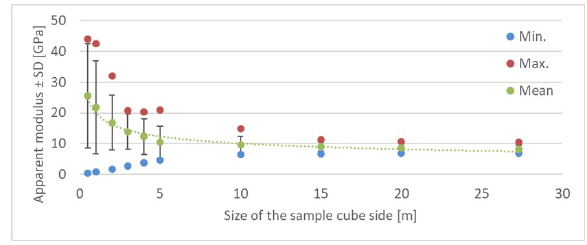
Figure 2. Apparent deformation moduli – x axis.